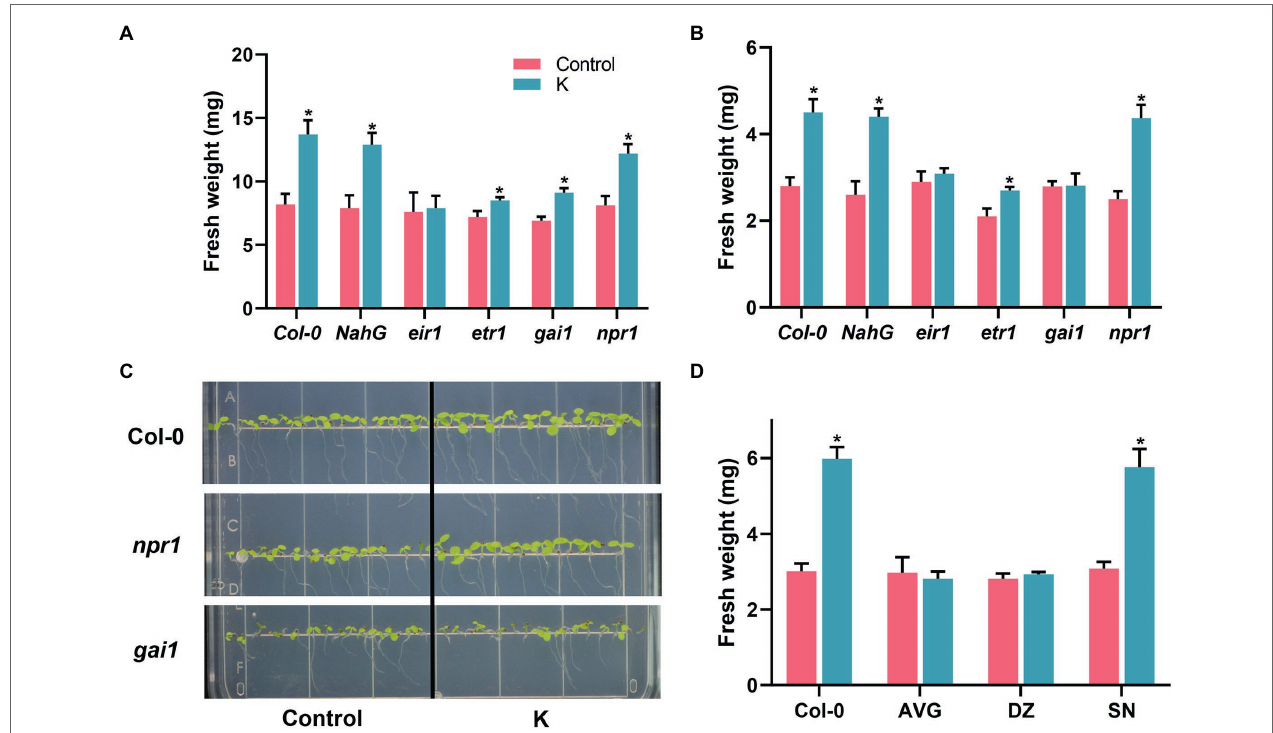
FIGURE 2 | Mucilaginibacter sp. K effects on growth performance of Arabidopsis Col-0 and mutant lines under unstressed (A) and salt stress (B) conditions. Arabidopsis seeds treated with strain K were grown on MS medium supplemented with 100 mM NaCl or not. Fresh weight was recorded 21 days (unstressed) or 14 days (salt stress) after inoculation. (C) Representative 7-day-old seedlings of Col-0, npr1 , and gai1 grown on salt media were photographed. Inoculated seeds were sown on MS medium supplemented with 100 mM NaCl. (D) Effects of strain K on Arabidopsis growth treated with hormone inhibitor under salt stress. Arabidopsis seedlings (4-day-old) were transferred to MS medium supplemented with hormone inhibitors and 100 mM NaCl for 10 days. Data are presented as standard errors of six replicates ( * p <